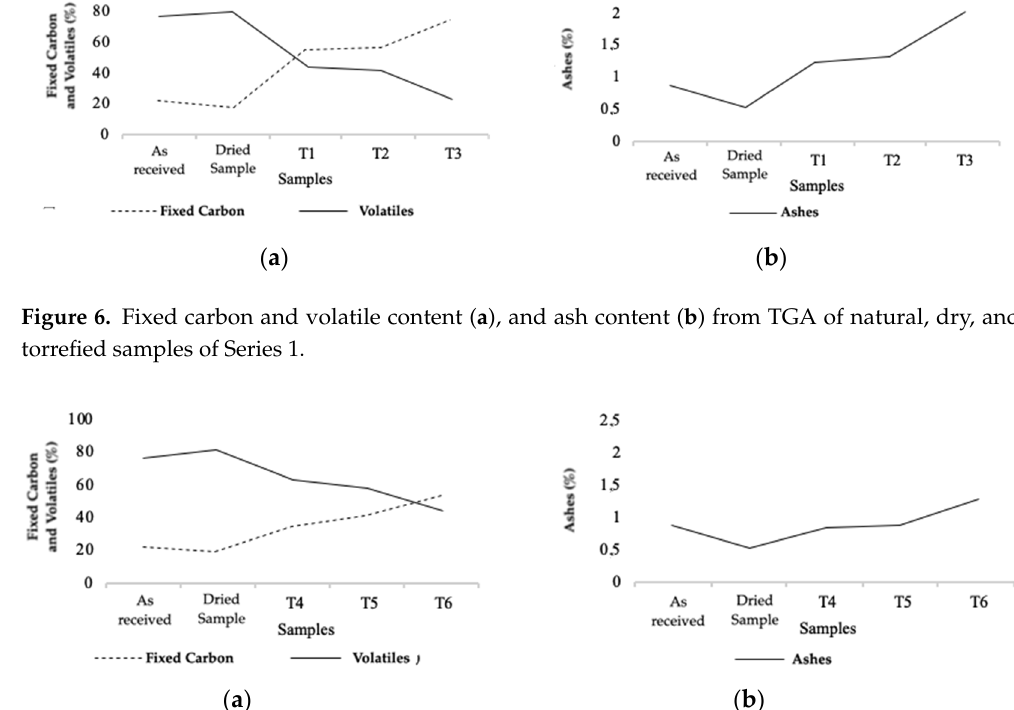
Figure 7. Fixed carbon and volatile content ( a ), and ash content ( b ) from TGA of natural, dry, and